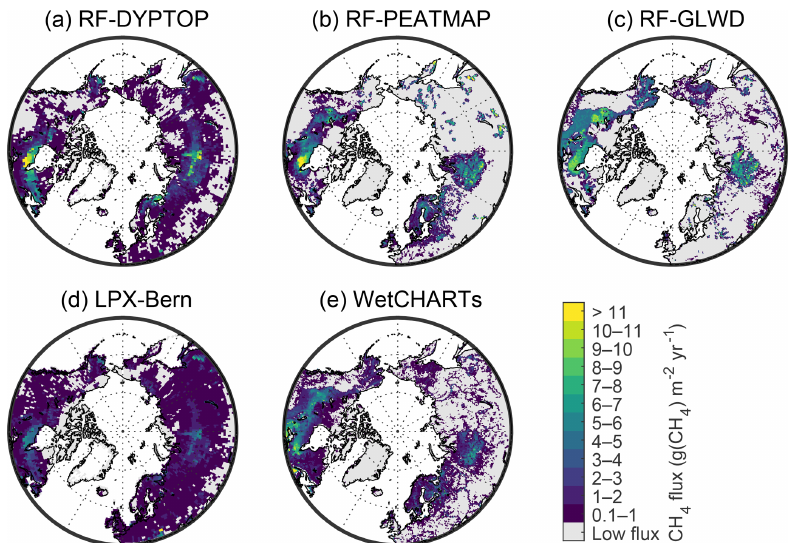
Figure 6. Mean annual CH 4 wetland emissions during years 2013–2014 estimated by upscaling EC data using the RF model and three wetland maps (a, b, c) and process models (d, e) . Grid cells with low CH 4 wetland emissions (below 0.1g(CH 4 )m − 2 yr − 1 ) are shown in grey. The flux rates refer to total unit area in a grid cell.